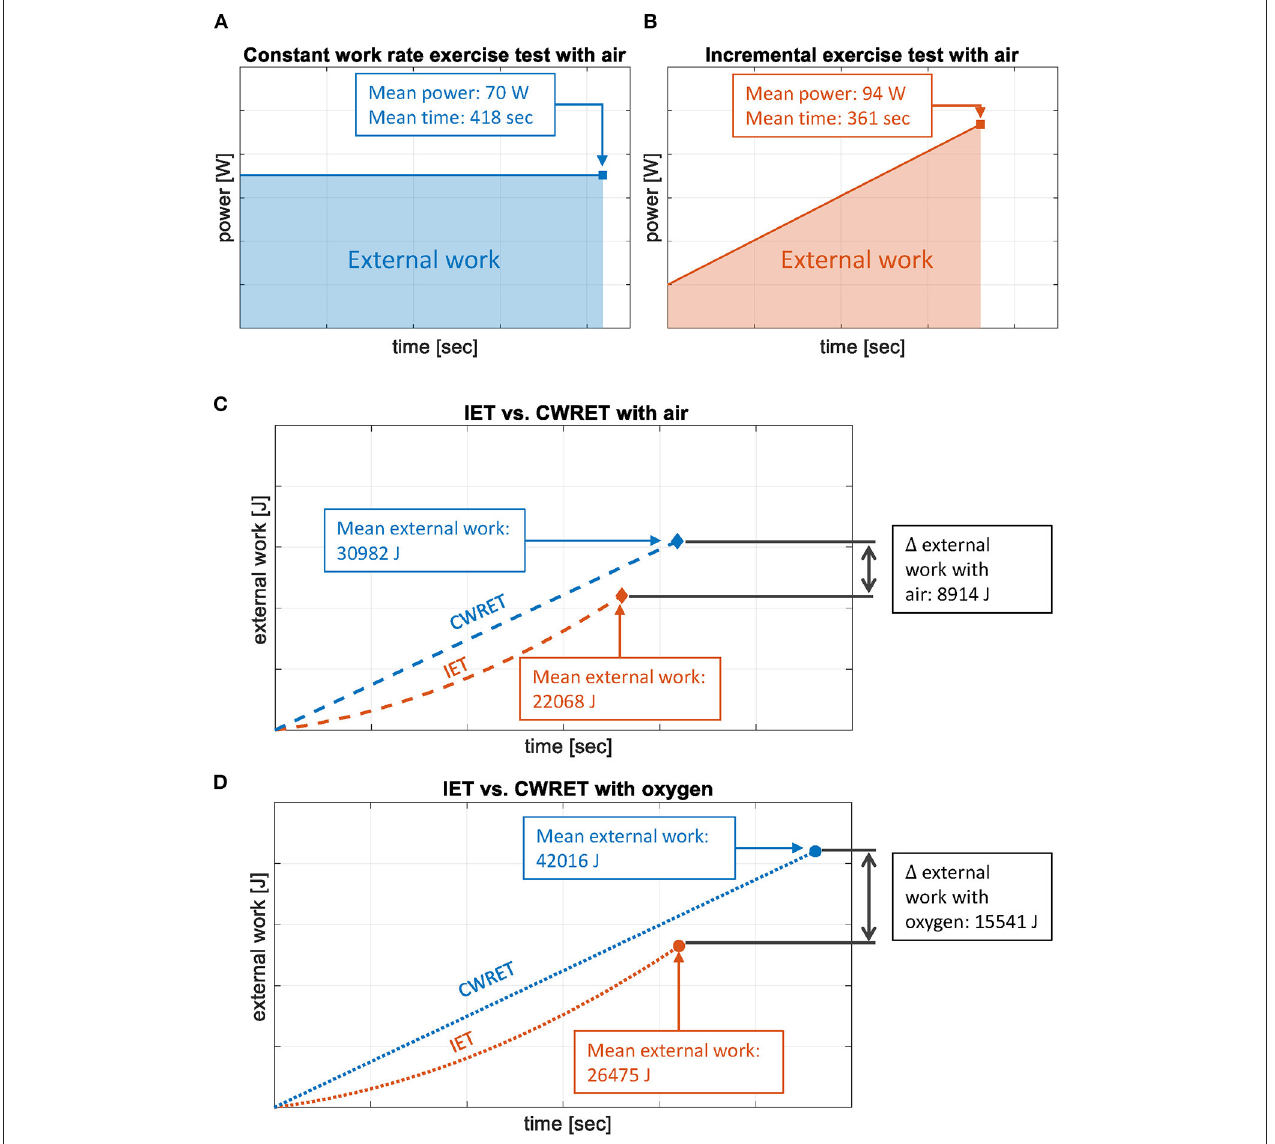
FIGURE 4 | Cycling energy delivery during incremental vs. constant work-rate exercise test (IET vs. CWRET). (A) Graphical representation of the constant work-rate exercise test (CWRET, blue) with air for a mean cycling time of 418s and a mean work-rate of 70W. (B) Graphical representation of the incremental exercise test (IET, red) with air for a mean cycling time of 361s and a mean work-rate of 94W, starting with 20W. (C) Graphical representation of the mean delivered external work of the patients, calculated with the integral of the work-rate over cycling time, comparing both tests [CWRET (blue); IET (red)] with air. The curves represent the estimated progress with time for both tests. (D) Graphical representation of the mean delivered external work of the patients, calculated with the integral of the work-rate over cycling time, comparing both tests [CWRET (blue); IET (red)] with oxygen. The curves represent the estimated progress with time for both tests. R W dt = external work